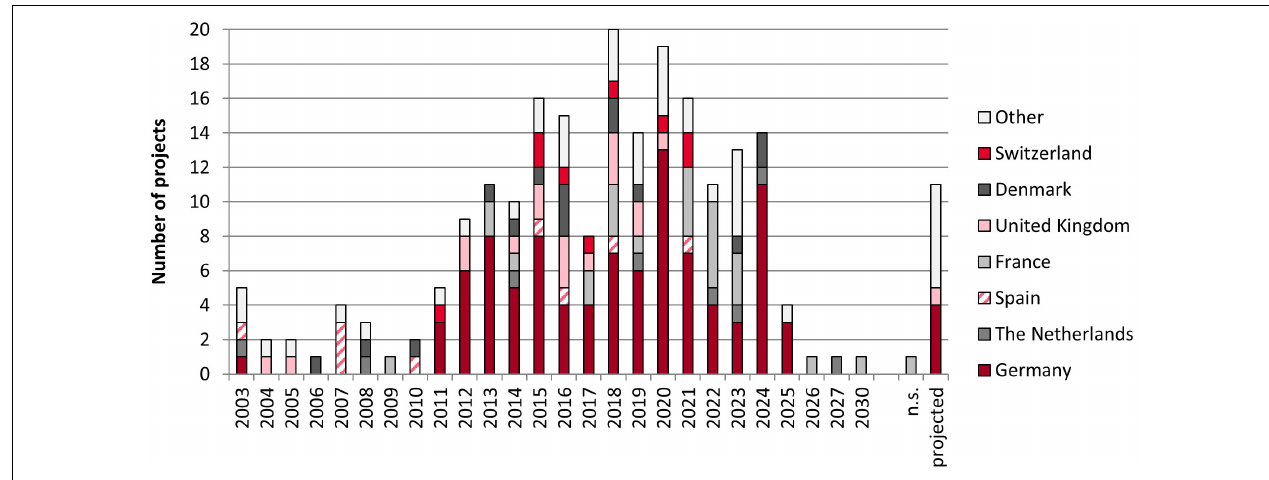
FIGURE 2 | Historical development of Power-to-X projects commissioned in Europe with regard to the countries involved; year for commissioning not specified (n.s.).